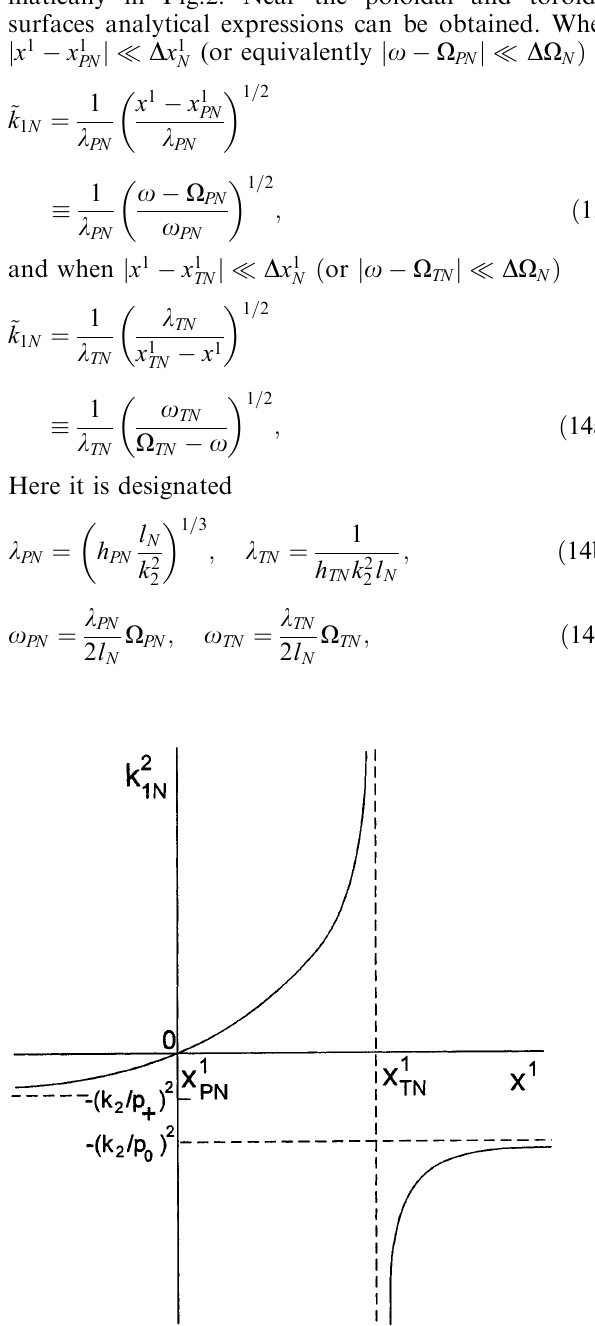
Fig. 2. Dependence of the component ~ k 2 wave vector of the standing Alfve´ n wave on the radial coordinate x 1